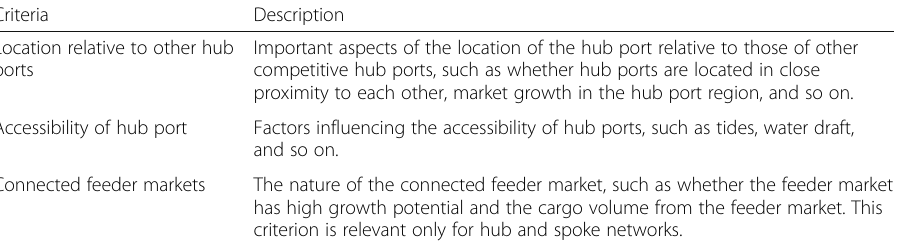
Table 5 Criteria Related to the Location Category